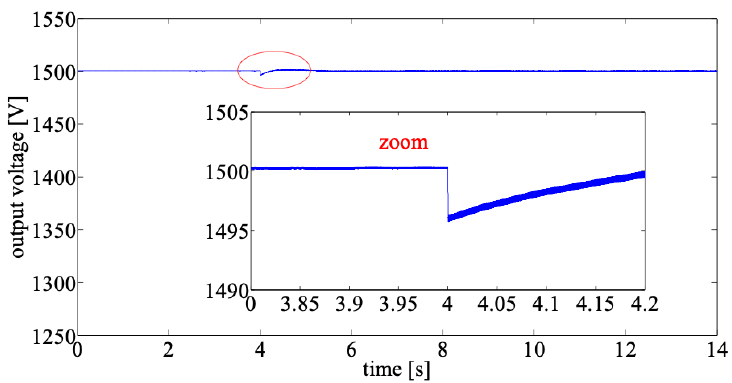
Figure 10. Output voltage dynamic behavior (case A).